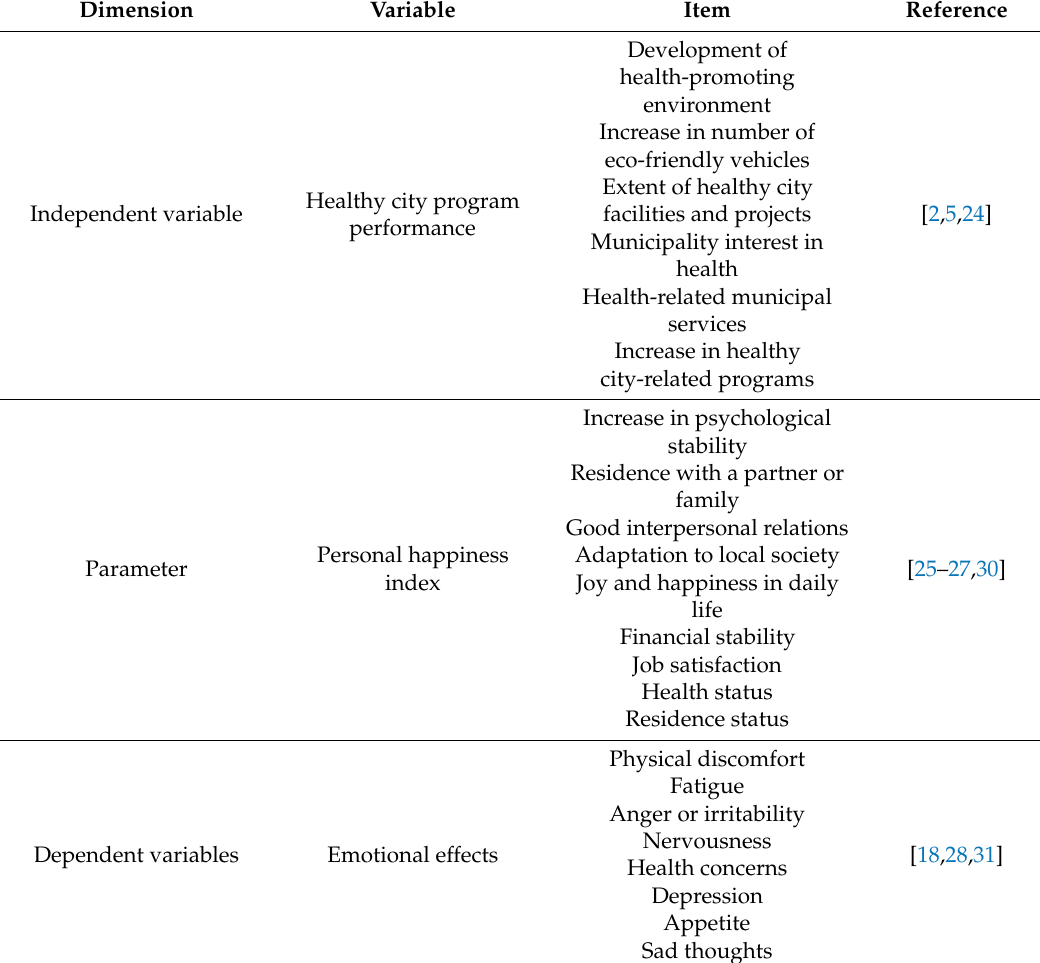
Table 1. Composition of the